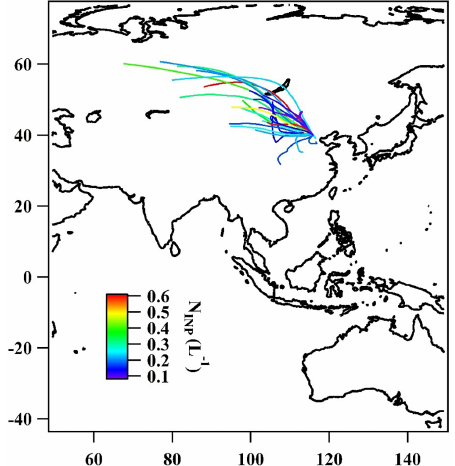
Figure 9. The 2-day back-trajectories obtained by the NOAA HYS- PLIT model color-coded with respect to INP